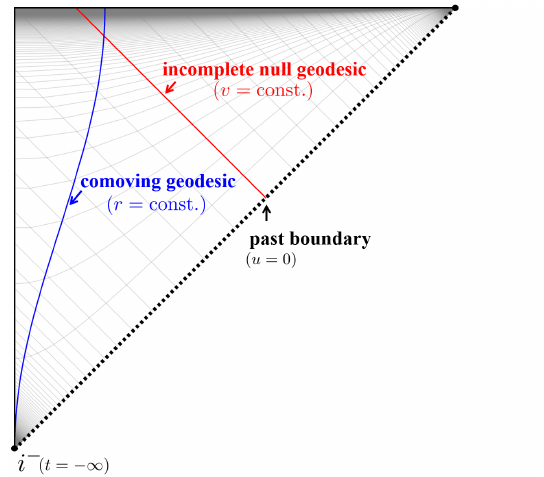
Figure 1 . A typical Penrose diagram of quasi de Sitter spacetime: the comoving geodesic ( r = constant) is past complete and approaches i − in an infinite proper time t . On the other hand, the null geodesic ( v = constant) is past incomplete and approaches the past boundary (the dashed line) in a finite affine length u . The metric has at least continuous extension beyond the past boundary, though the curvature could be a parallelly propagated curvature singularity depending on the scale factor. We note that this is a diagram with future complete null geodesics, though the future structure is irrelevant to our discussion in this